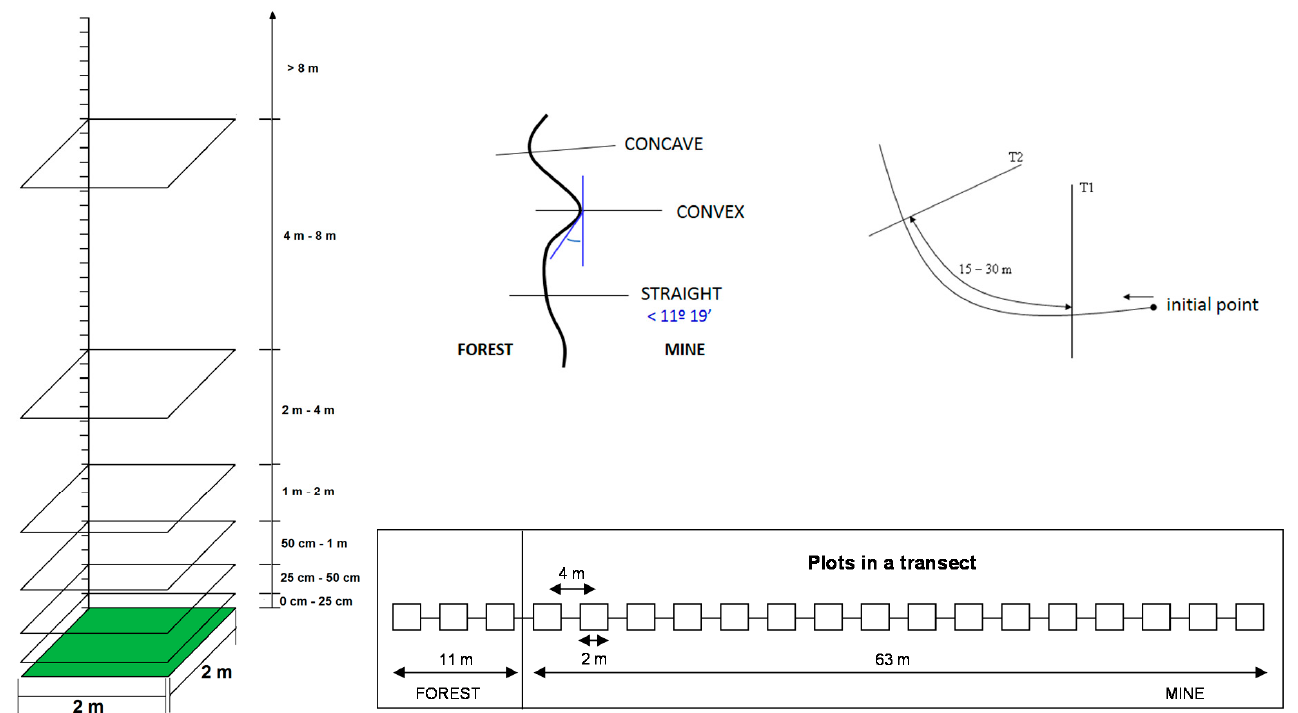
Figure A1. Location of the study sites in Northern Spain.